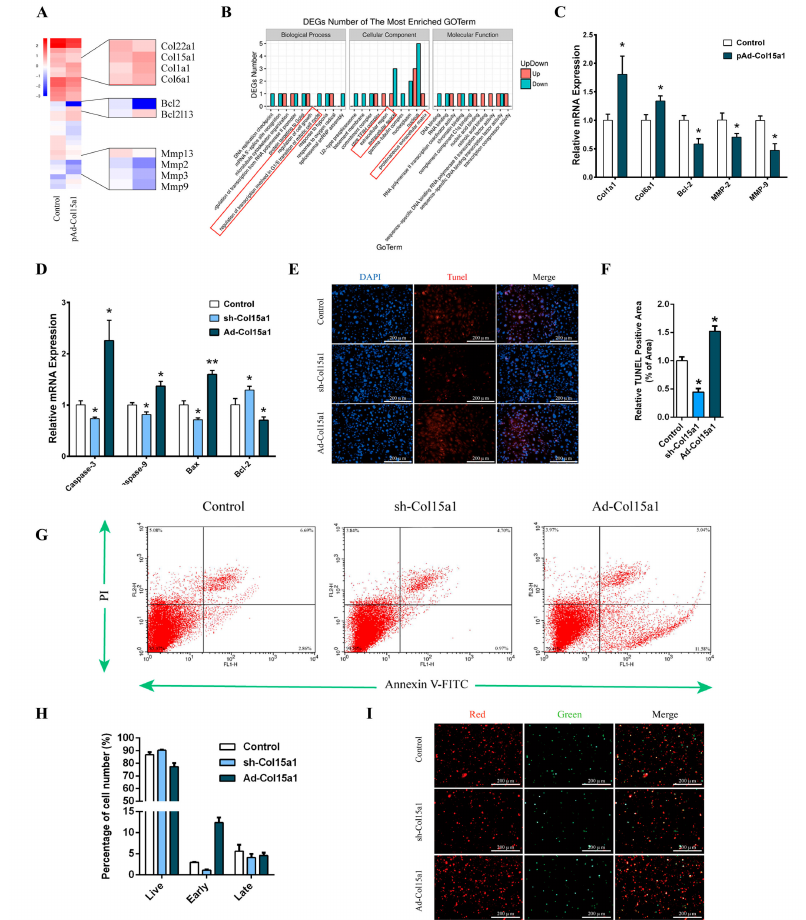
Figure 1. Collagen XV (ColXV) involved extracellular matrix (ECM) remodeling and triggered apoptosis in adipocytes. ( A ) Heatmap of genes set from RNA-seq data with forced expression of ColXV in mice adipocytes, along with the top a ff ected genes ( n = 4). ( B ) Gene ontology (GO) analysis of the altered genes in ( A ) ( n = 3). ( C ) Changes in the mRNA level of genes associated with apoptosis and ECM remodeling, which were significantly altered from RNA-seq analysis ( n = 4). ( D ) Relative mRNA expressions of Caspase-3, Caspase-9, Bax, and Bcl-2 in mice adipocytes in di ff erent groups ( n = 4). ( E – F ) Tunnel staining of DNA fragments in adipocytes. Scale bar, 100 µ m ( n = 4) ( G – I ) Annexin V-FITC / PI double staining and flow cytometry analysis of adipocytes apoptosis. Scale bar, 100 µ m ( n = 4). Values are presented as mean ± SEM. * p < 0.05, ** p <